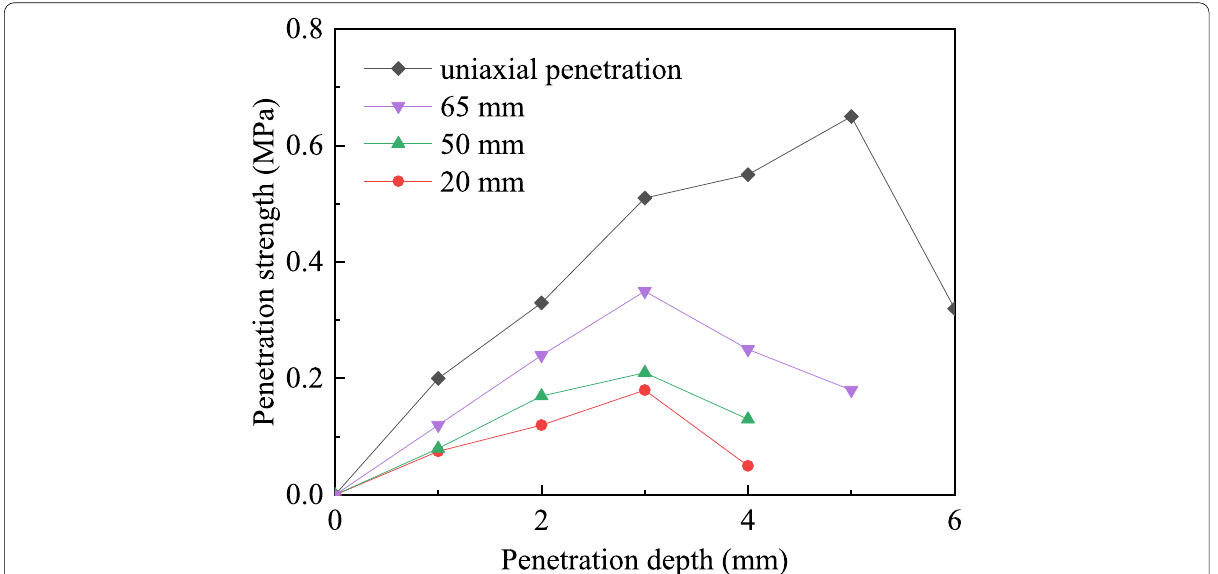
Fig. 13 Penetration curves with different wheel